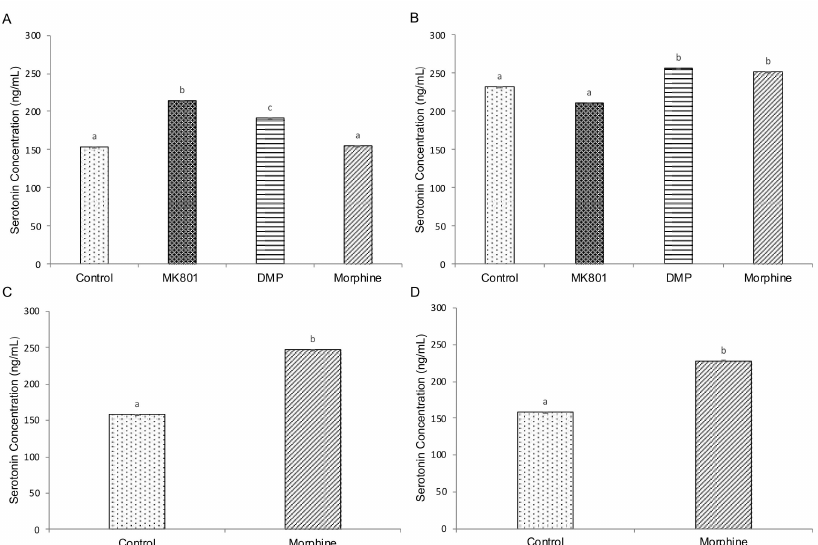
Figure 5. Effects of ( A ) short-term (F (3,32) = 16.064, p < 0.001) and ( B ) long-term (F (3,32) = 11.777, p < 0.001) exposure to MK801, DMP and morphine, and ( C ) short-term ( t (16) = 4.531, p = 0.001) and ( D ) long-term ( t (16) = 2.032, p = 0.019) morphine withdrawal on whole-body serotonin concentration in zebrafish larvae. Data expressed as mean ± SEM, n = 50 of 3 independent experiments. Different lowercase letters indicate statistically significant values, p < 0.05. DMP: domperidone.